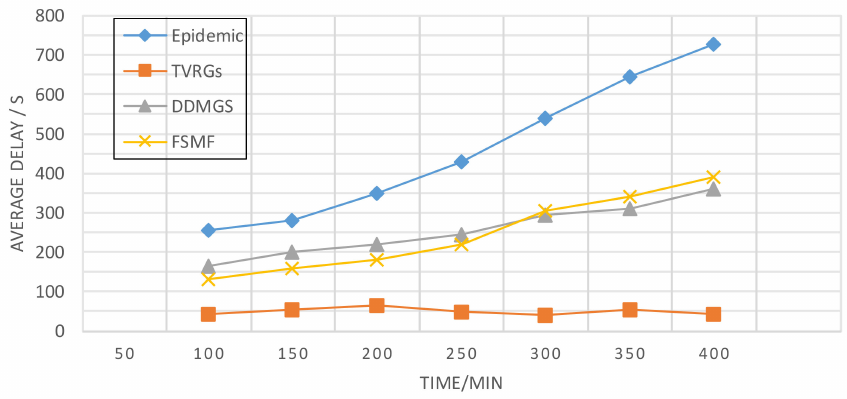
Figure 9. The relationship between average delay and simulation